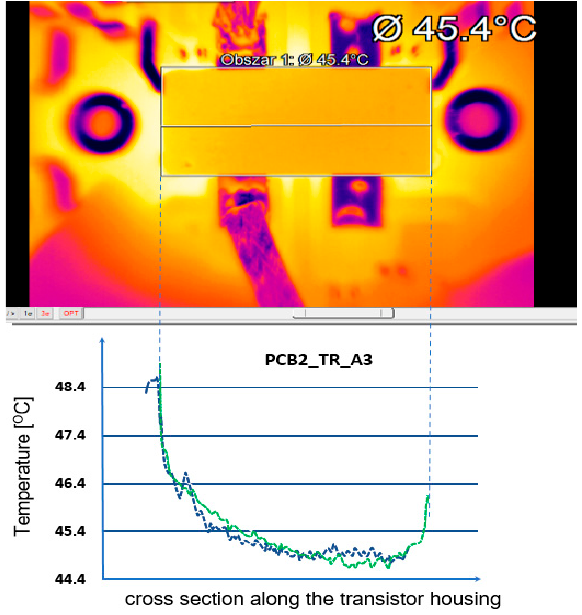
Figure 12. Thermogram and the case temperature distribution measured for the BLC10G22LS-240PVT transistor with the dissipated power P D = 6.74 W.